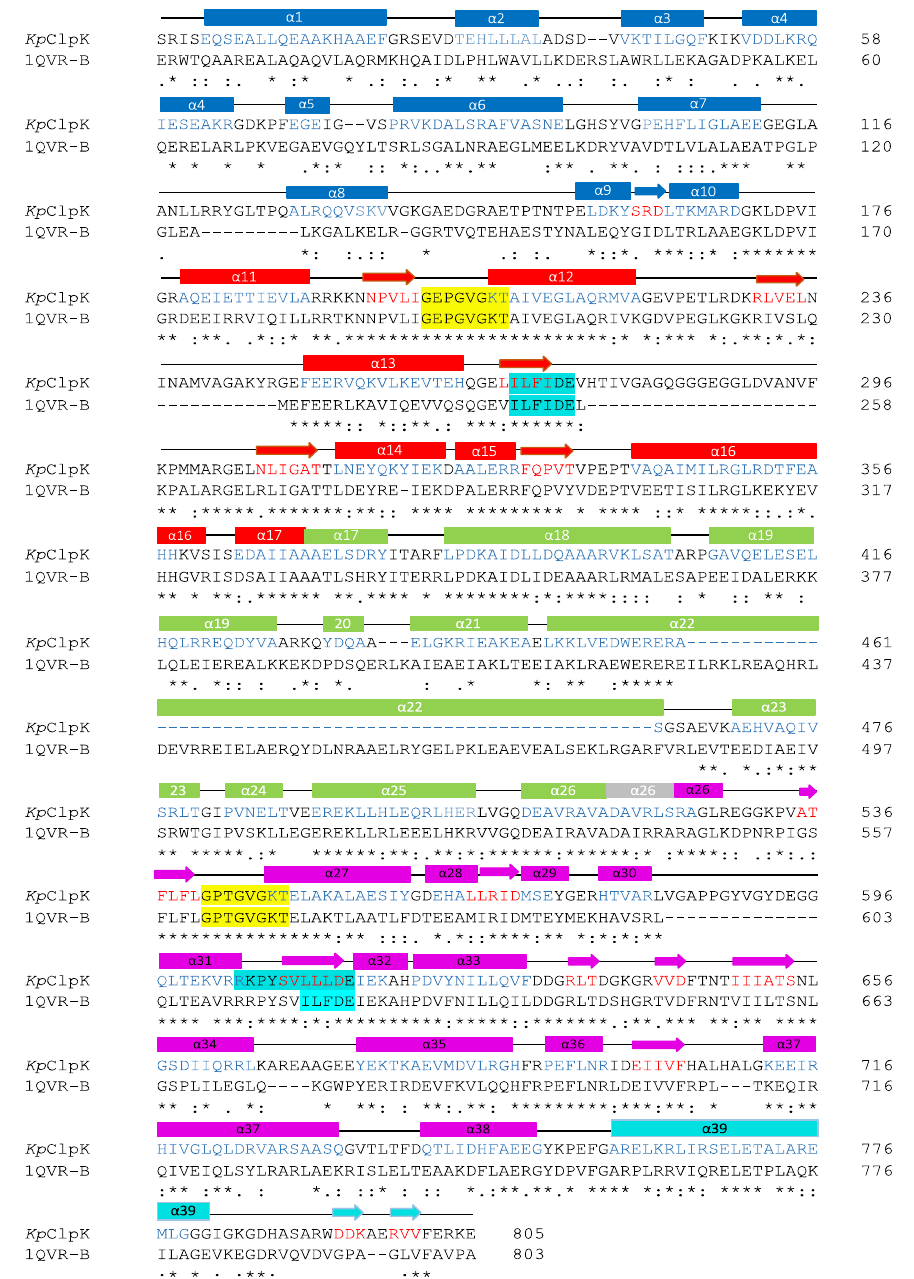
Figure 5. Alignment of ClpK with ClpB. The annotations were done according to sequence ClpB (1QVR-B). The α -helices and β -sheet are shown as rectangles and arrows, respectively. ClpK residues colored blue represent the position of the α -helices whereas red residues represent the position of the β -sheet. Asterisks (*) denote the identical residues, (:) represents sequence homologies, and (.) represents weak similarity. The five domains are shown as follows: N-terminal domain (blue); D1 large domain (red); D1 small domain (green); short linker region (grey); D2 large domain (pink); D2 small domain/C-terminal domain (cyan). The secondary structure elements are colored according to the domain. Walker A and Walker B motifs are highlighted yellow and cyan, respectively. The alignment was performed using T-COFFEE [32].